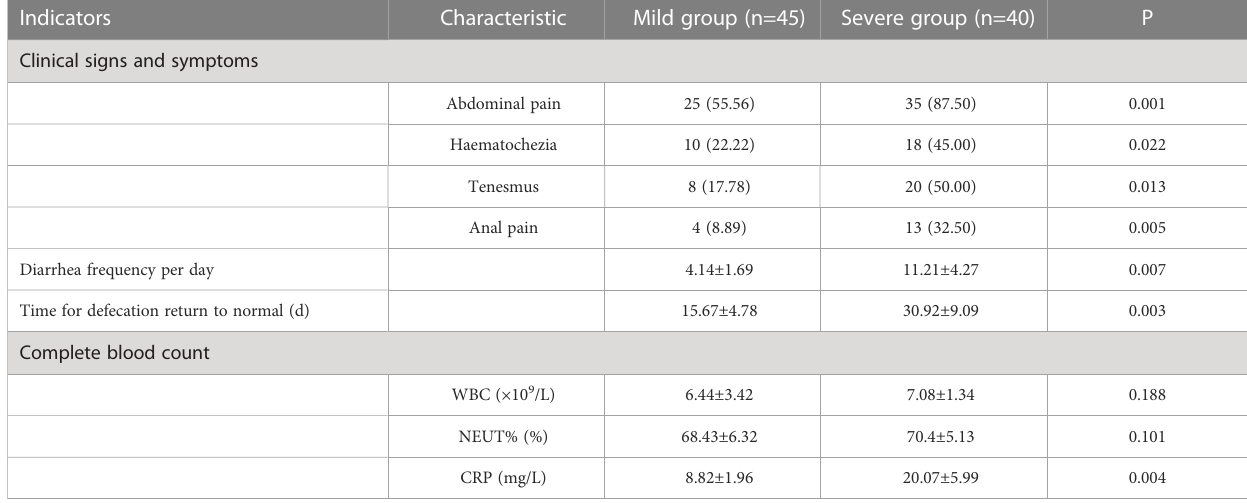
TABLE 2 Analysis of Clinical follow-up data of two groups after closure of temporary ileostomy (n/%, x s